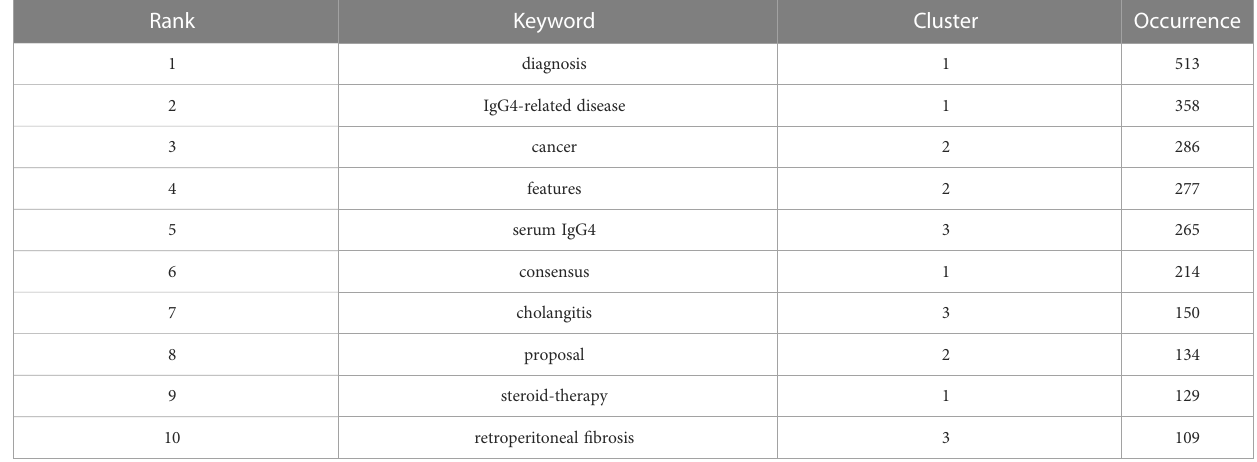
TABLE 6 The top 10 most common